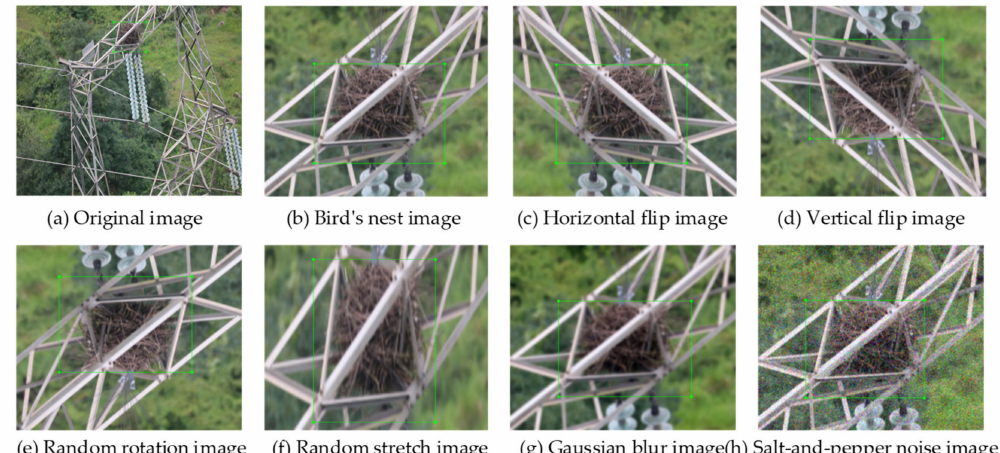
Figure 7. Schematic diagram of bird’s nest samples after data